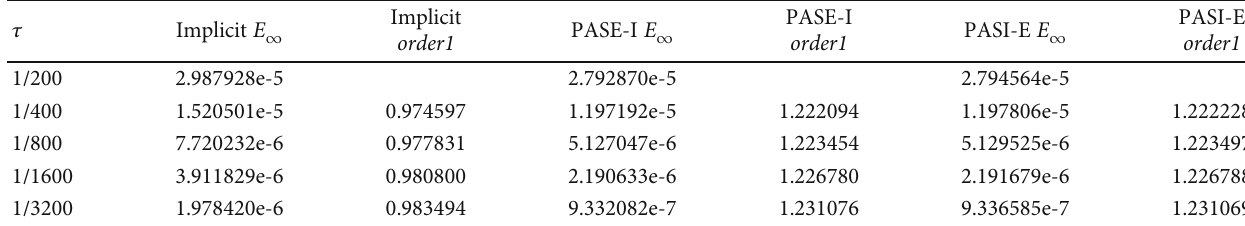
Table 1: Time order ( order1 ) of di ff erence schemes ( h = 1/200 ).